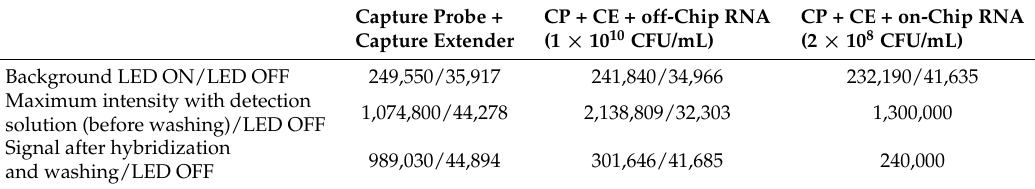
Table 3. Average fluorescence intensities in photon counts per